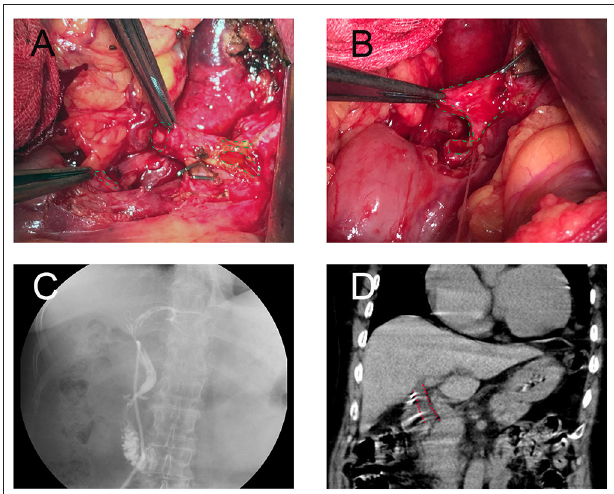
FIGURE 2 | A patient with type E2 combined with type D (Strasberg-Bismuth) bile duct injury (BDI) underwent FMS end-to-end biliary-to-biliary reconstruction. (A) Intraoperative photograph of bile duct before shaping, bile duct gaps were represented by a green dashed line. (B) Intraoperative photograph of bile duct after fish mouth shaping, the bile duct was reshaped as a fish-mouth. (C) T-tube cholangiography before T-tube removed. (D) CT-scan at year 2 postoperative. The common bile duct was highlighted (red dashed line), no stenosis was